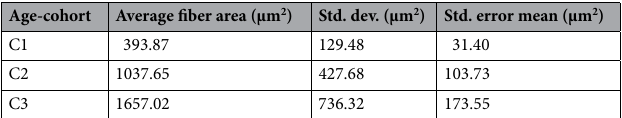
Table 4. Average fiber area (μm 2 ), standard deviation (μm 2 ) and standard error (μm 2 ) for each muscle of a subset of each age-cohort (C1 = 3 weeks old; C2 = 8 months old; C3 = 2 years old) and the connecting letter report from a Tukey’s HSD test comparing the three groups.